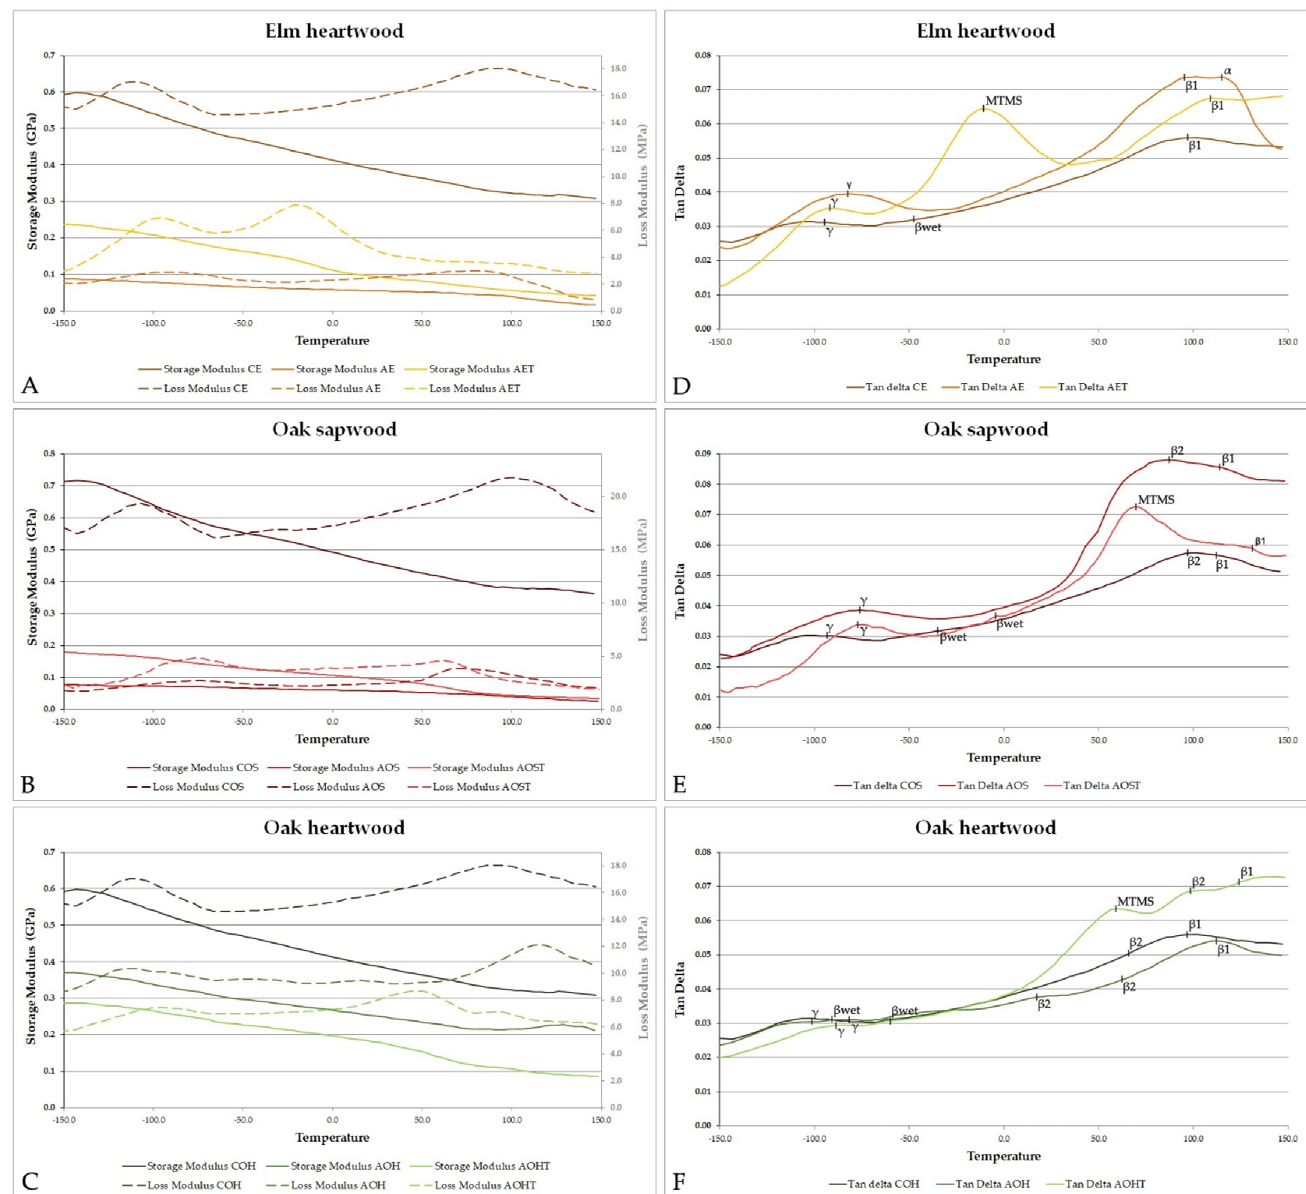
Figure 5. Comparison of storage modulus (E’), loss modulus (E”) ( A – C ) and loss factor (tan delta) ( D – F ) exemplary graphs for air-dried contemporary, archaeological untreated and MTMS-treated elm and oak wood with mean values of specific tan delta peaks marked.